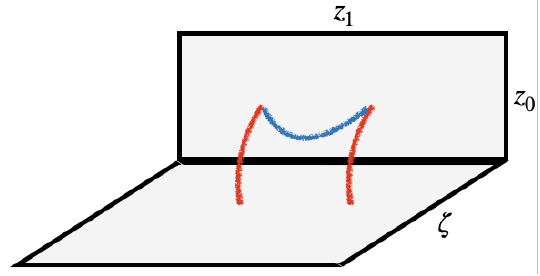
Figure 12 . The extremal surface can either be in the connected regime (blue) or disconnected regime (red) where it terminates on the EoW